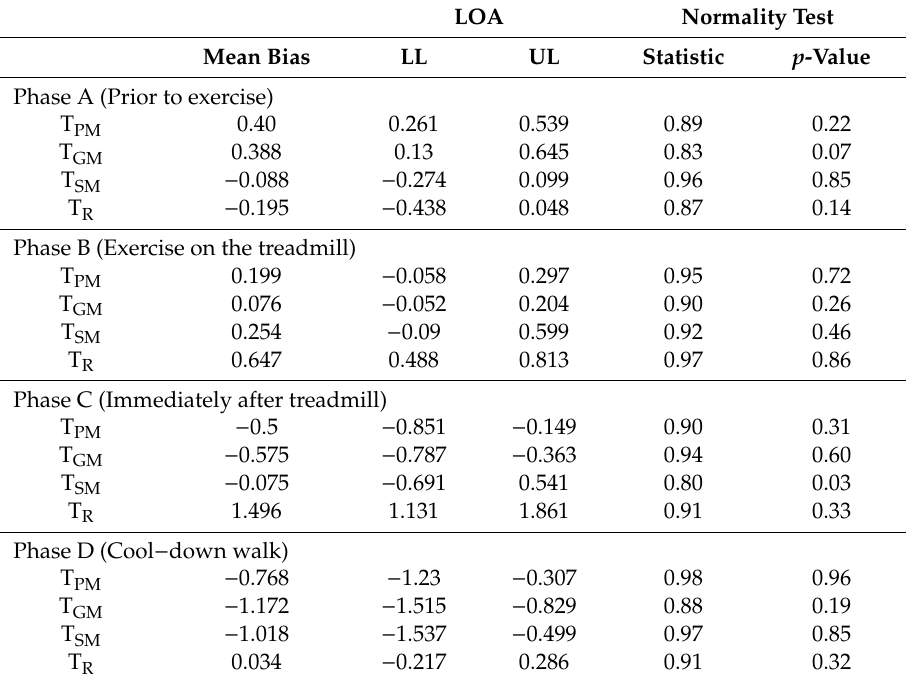
Table A2. Limit of agreement (LOA) for body temperature readings of horses before, during, and after treadmill exercise.